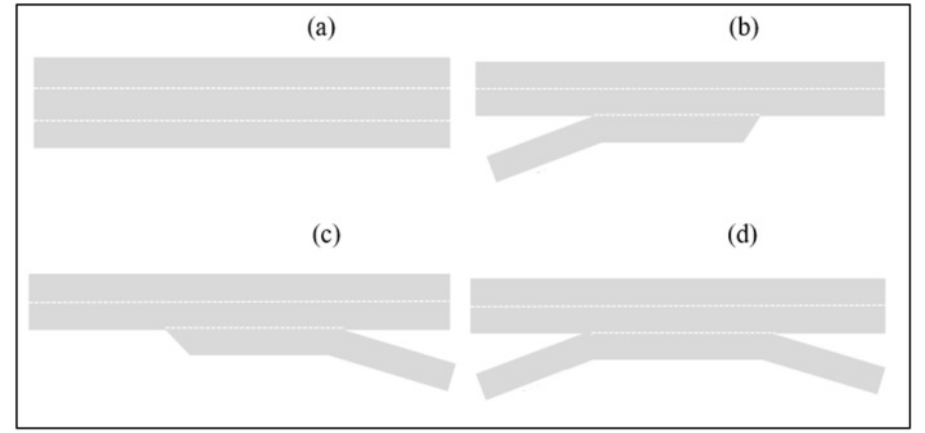
Figure 2. The geometric configuration of investigated freeway segments: ( a ) basic freeway, ( b ) merg- ing, ( c ) diverging, and ( d ) weaving.